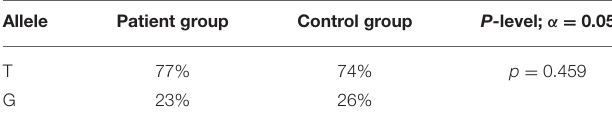
TABLE 3 | Allele frequencies distribution of MIR137 rs1625579 polymorphism among schizophrenia patients and healthy controls. Allele Patient group Control